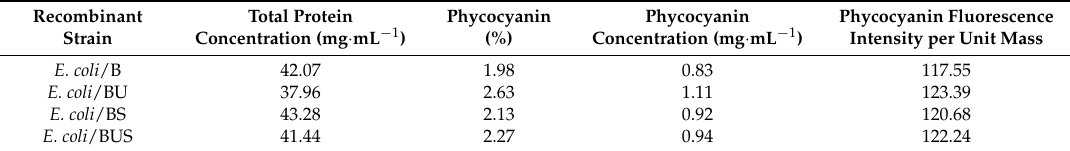
Table 2. Quantitative and fluorescence intensity analysis of phycocyanin in BU, B(C82)U, and B(C153)U. Recombinant